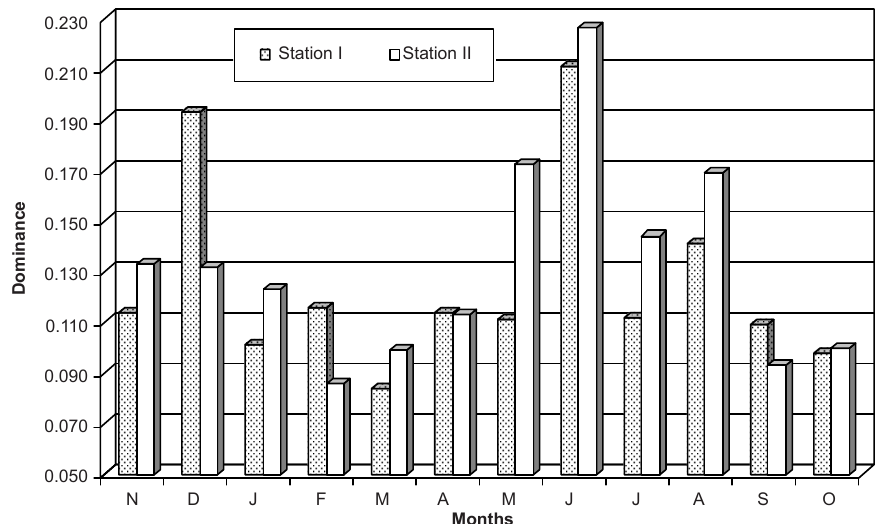
Figure 8. Monthly variations in dominance of Rotifera